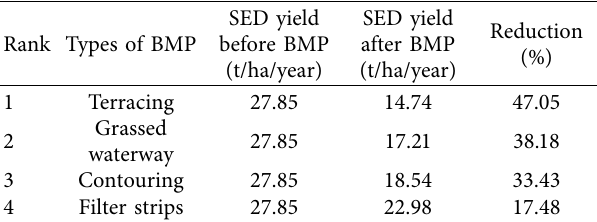
Table 17: Sediment yield reduction effectiveness and rank of BMPs on Awata watersheds.